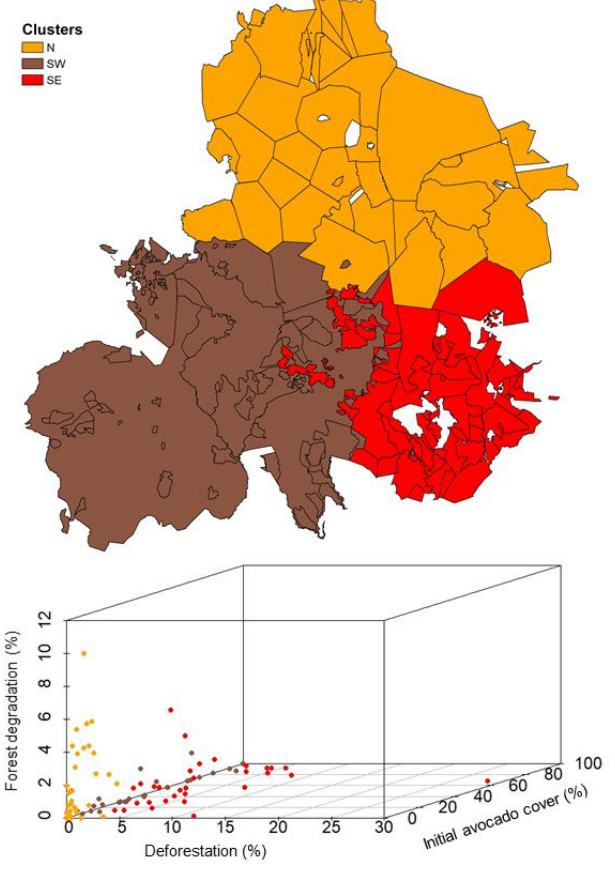
Fig. 2 . Cluster analysis regarding forest-cover change (FCC) patterns per community.